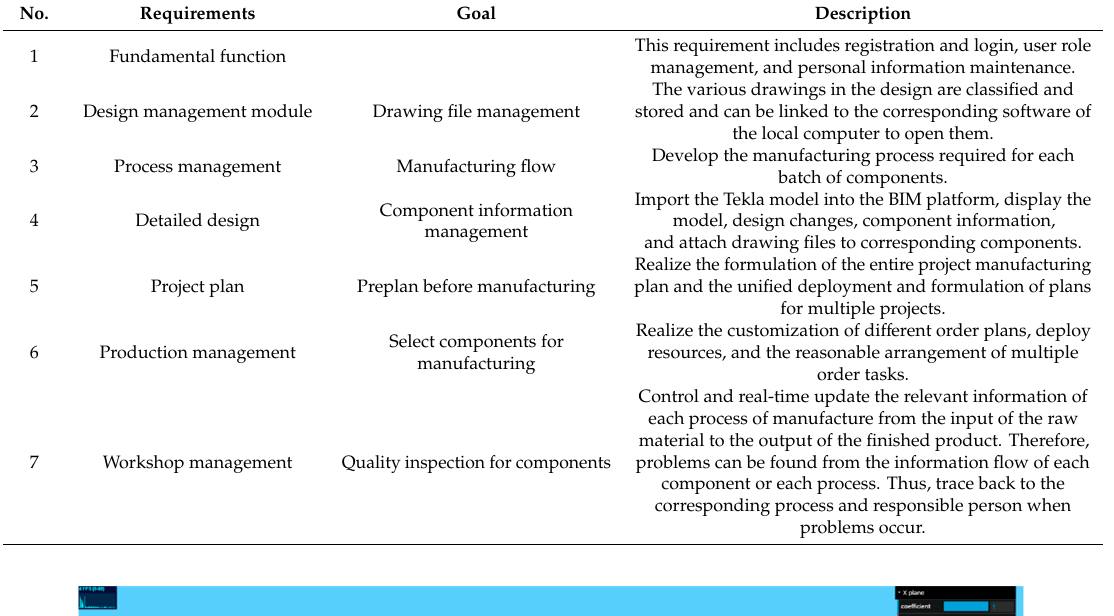
Table 2. Functional requirements.